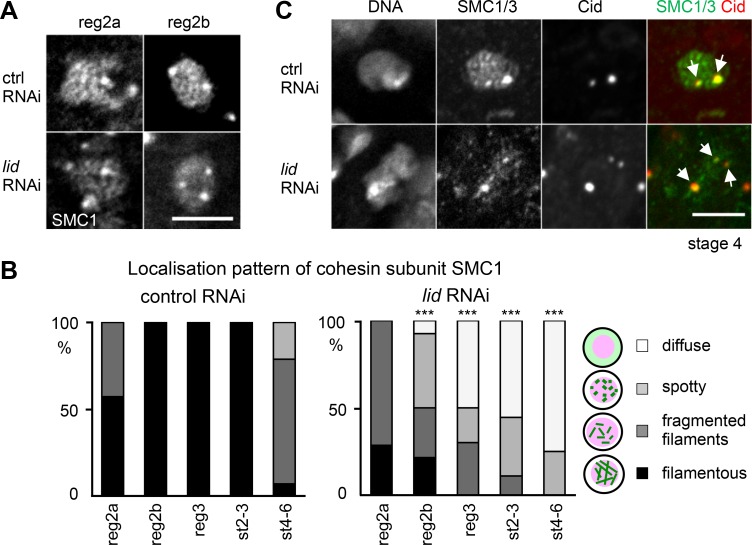
Loss of Kdm5/Lid leads to instability of chromosome cores along arms but does not affect persistence at centromeres.(A) SMC1 signals in meiotic nuclei in region 2a and 2b of control and Kdm5/lid RNAi ovaries, showing filamentous patterns in control, and fragmented filaments in region 2a and mainly diffuse pattern in region 2b of Kdm5/lid RNAi ovaries. (B) Quantification of SMC1 staining pattern in control and Kdm5/lid RNAi meiotic nuclei. *** indicates a significant difference in the pattern distribution from the control (p<0.001). n≥7. Chromosome cores visualised by filamentous SMC staining fails to be maintained in Kdm5/lid RNAi. (C) Centromeric SMC1/3 localisation in control and Kdm5/lid oocytes at stage 4. Colocalisation between Cid and SMC1/3 foci was observed in all oocytes examined (n = 13 for stage 4–6). Arrows indicate Cid and SMC1/3 foci. Scale bars = 5 μm.